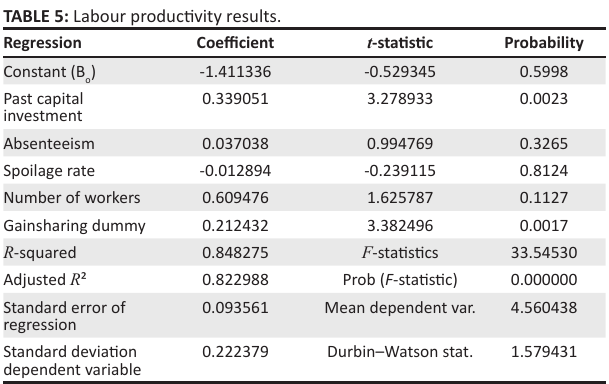
TABLE 6: Labour productivity results with capital investment lagged by 1 quarter. Regression